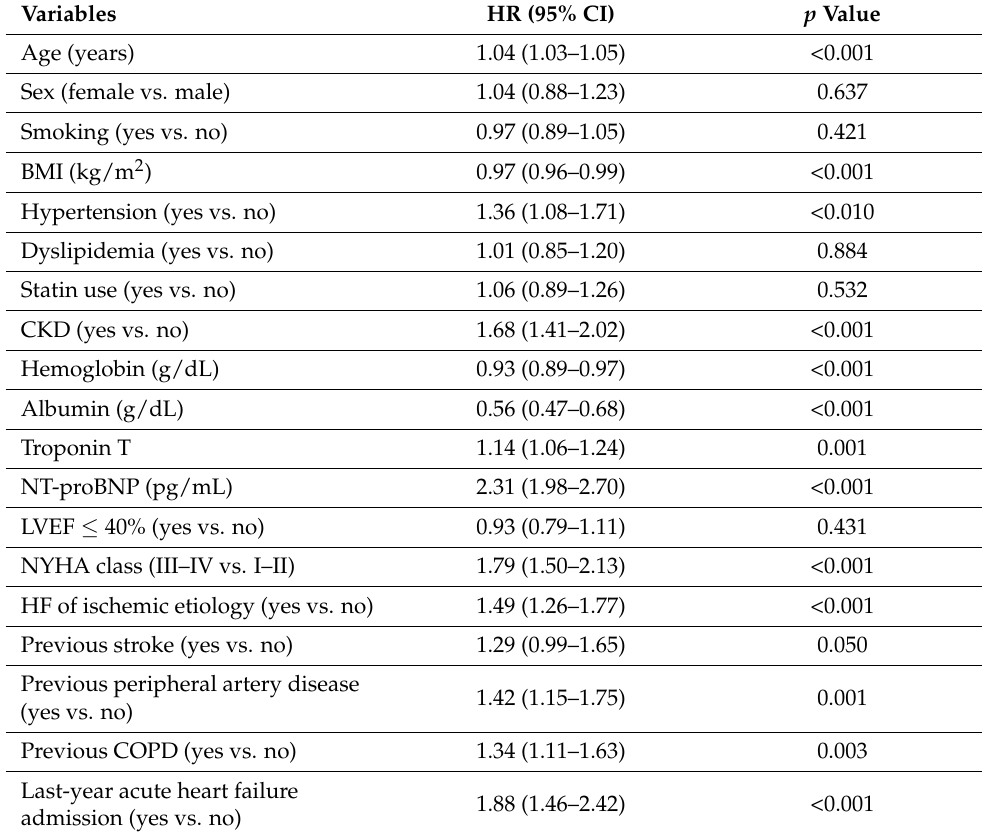
Table 2. Univariate Cox regression analysis of 4-year all-cause death.